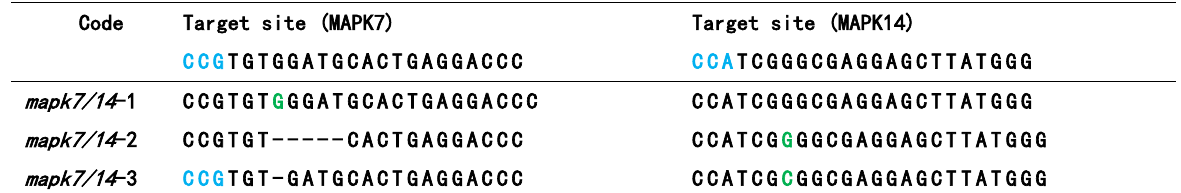
Table 3 Target sites of MAPK7/14 and sequences of target sites in knockout